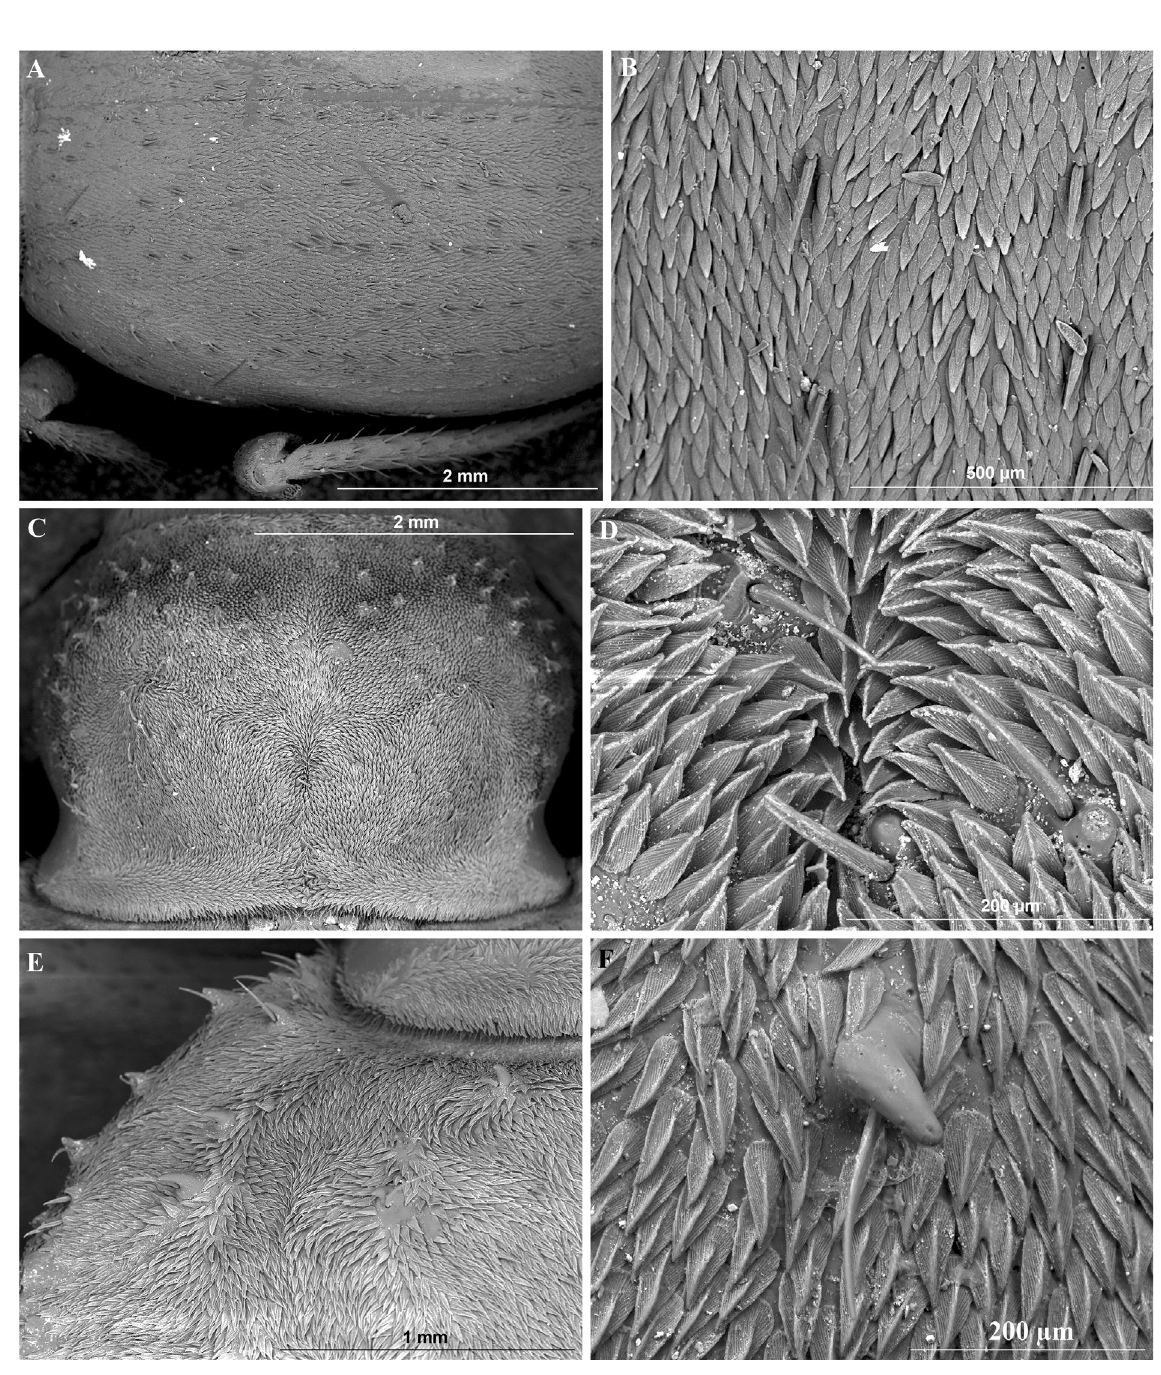
Fig. 9. Habrobates Semenov, 1903 and Dietomorpha Kühnelt, 1957, details of structure. A . H. vernalis Semenov, 1903, ♂, paralectotype (ZIN), left elytron. B . Ditto, elytral scales and rows of setae. C . D. pardalis Kühnelt, 1957, ♂ (ZIN), pronotum. D . Ditto, scales, setae and granules in middle of pronotum. E . Ditto, base of left elytron. F . Ditto, scales, spine-like tubercle and seta on